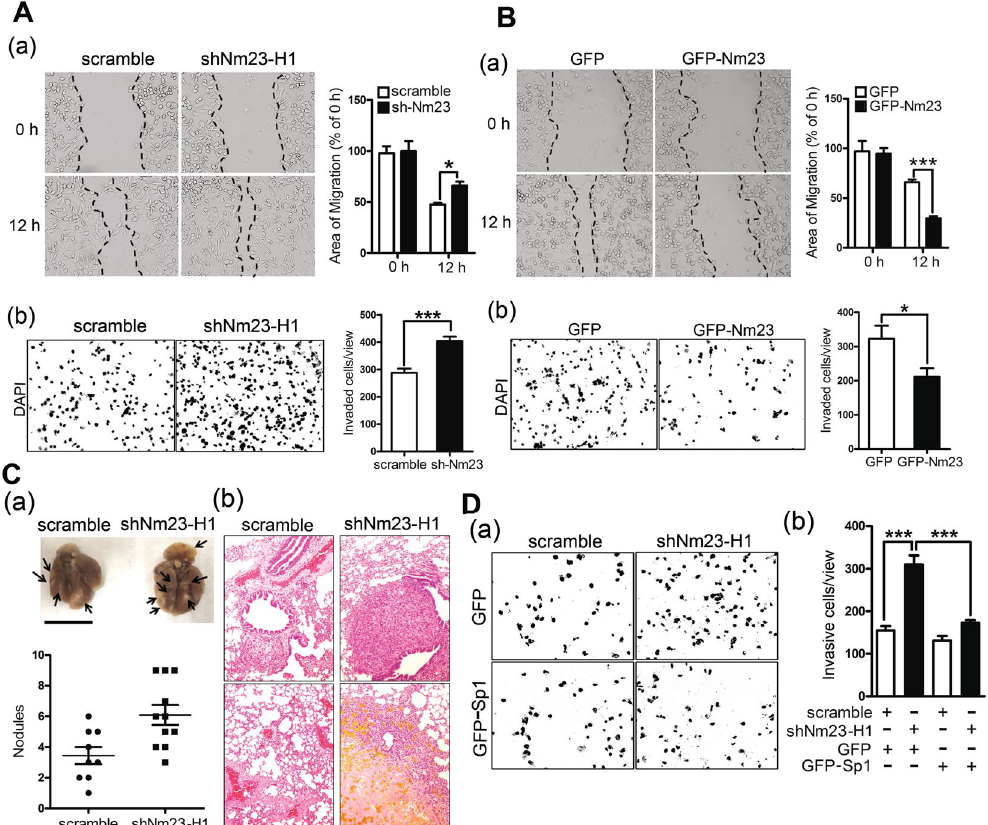
Figure 6. Nm23-H1-mediated Sp1 expression is involved in lung cancer malignancy. ( A , B ) The cell migration ability was assayed with a wound healing assay (a) and transwell assay (b) in Nm23-H1 knockdown ( A ) or GFP-Nm23-H1-overexpressed cells ( B ). After three independent experiments, the migratory area and cell number were quantified and statistical analysis was done with a t-test, * p < 0.05; *** p < 0.005. ( C ) CL1-5 cells with Nm23-H1 knockdown were injected into the lateral tail vein of SCID mice. Six weeks later, all mice were sacrificed and the number of tumor nodules was calculated (a). Tumor formation on the lung was studied by H&E staining (b). ( D ) Cell mobility was assayed in the Nm23-H1-silenced cells with or without GFP-Sp1 expression by transwell assay (a). After three independent experiments were finished, the cell number in the chamber was quantified, and the statistical analysis was performed with a t-test, *** p < 0.005